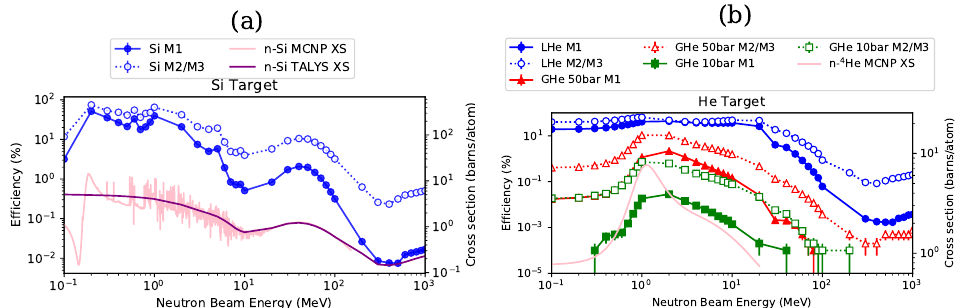
Figure 3. ( a ) Efficiency with a 10 cm 3 Si cube. Blue solid curve shows the triple consecutive scattering efficiency using the M1 while the blue dotted curve shows the two consecutive scattering efficiency using the M2. The pink curve shows the neutron–silicon cross section used in the MCNP-6.2 and the purple curve shows the cross section calculated by TALYS-1.95. ( b ) Efficiency with a 1 m 3 He cube. Blue curve is liquid, red is 50 bar gas, and green is 10 bar gas, while the solid curves represent the one using the M1 and the dotted curves represent the one using the M2. The pink curve shows the neutron- 4 He cross section used in the MCNP, while TALYS-1.95 [4] does not calculate the neutron- 4 He cross